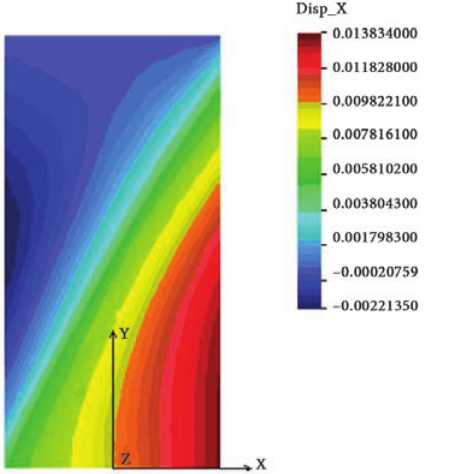
Fig. 7. Distribution of horizontal soil displacements u x in the sample with fixed ends